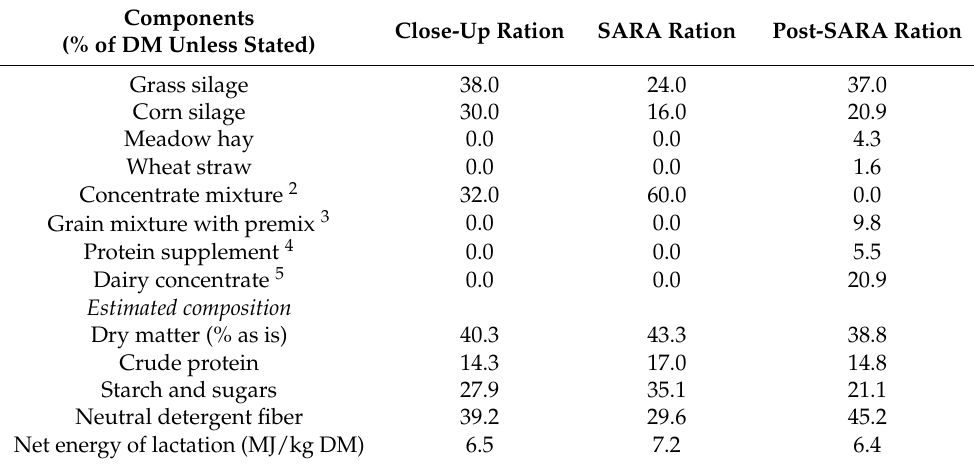
Table 1. Composition of close-up ration, SARA ration, and post-SARA ration.